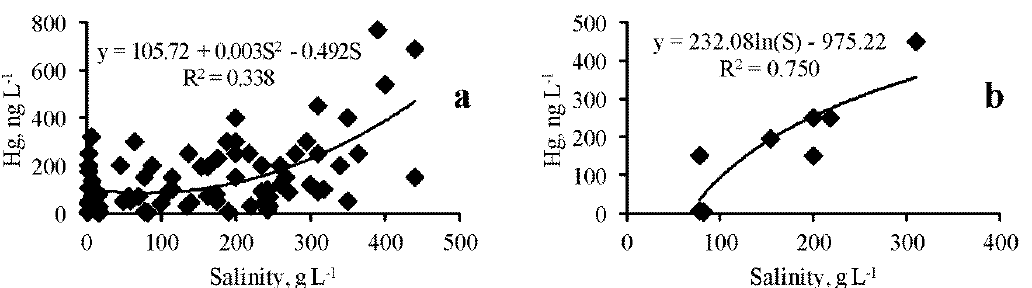
Figure 5. Dependence of the Hg suspended form concentration on salinity (( a )—for the entire collection of lakes in general, ( b )—Lake Kiyatskoye).